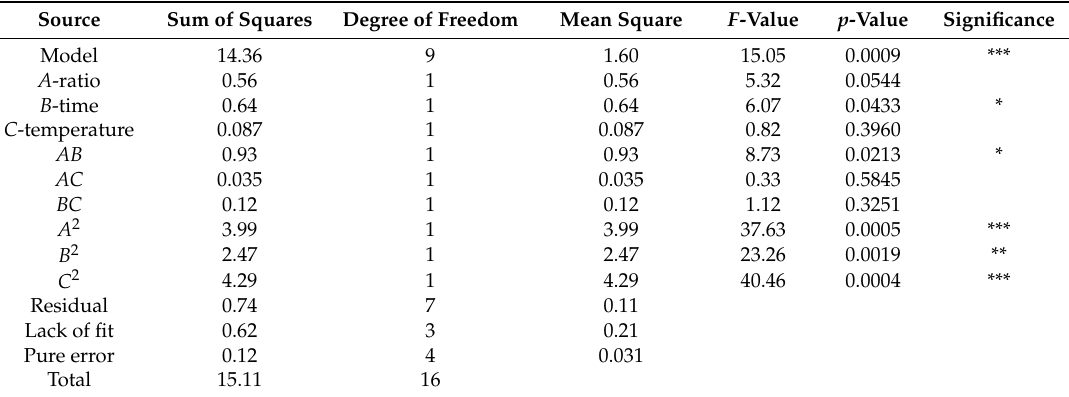
Table 2. Results of regression analysis and ANOVA for the fitted quadratic polynomial models. Source Sum of Squares Degree of Freedom Mean Square F -Value p -Value Significance